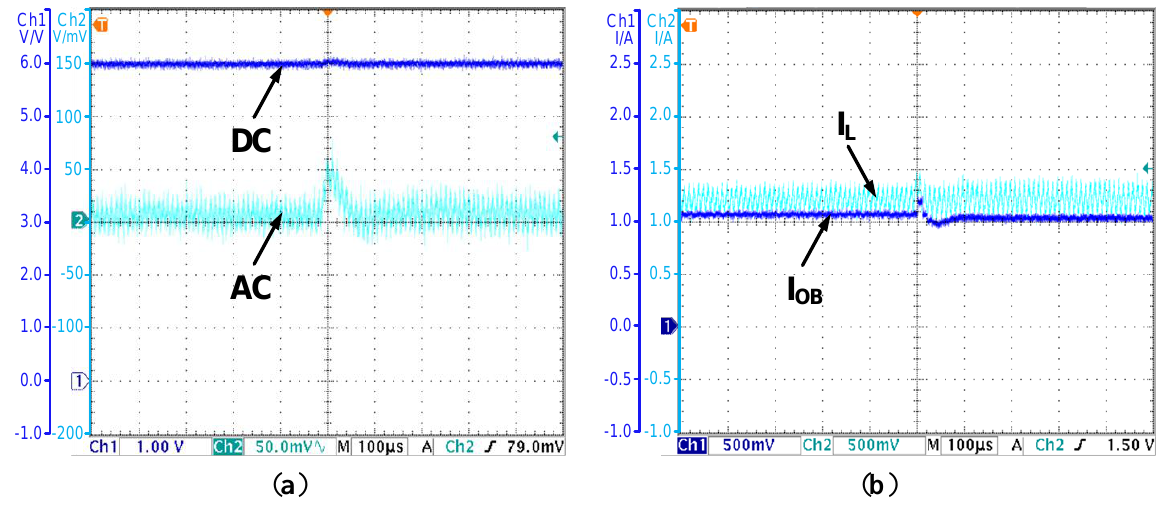
Figure 13. ( a ) The output voltage transient when the input voltage steps from 10 to 12 V—the OCO based PCC controlled converter; ( b ) The observed current and the inductor current transient when the input voltage steps from 10 to 12 V—the OCO based PCC controlled